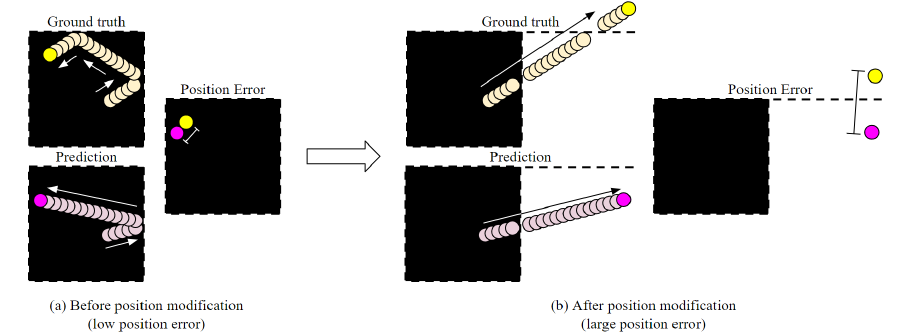
Figure 9. Position conversion process for position error calculation in fast-drifting ball (FDB).